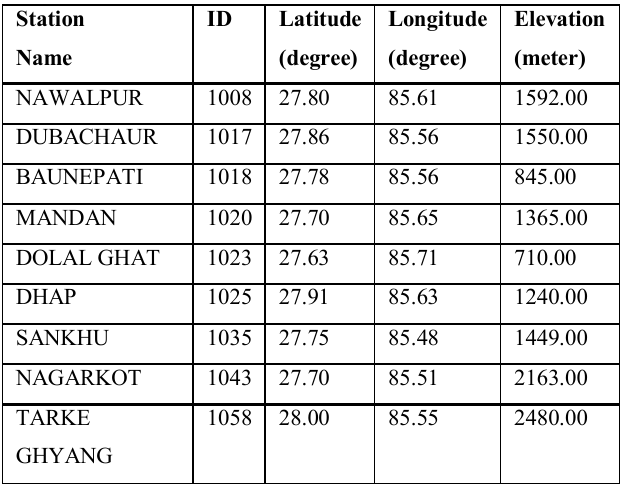
Table 1. Meterological station in project site